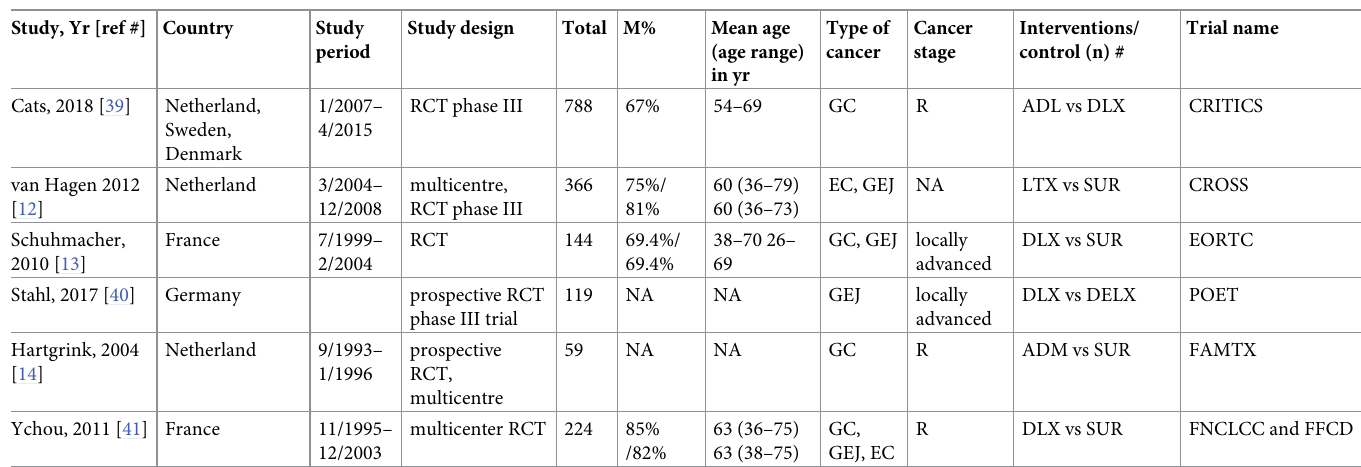
Table 2. Characteristics of the included studies.